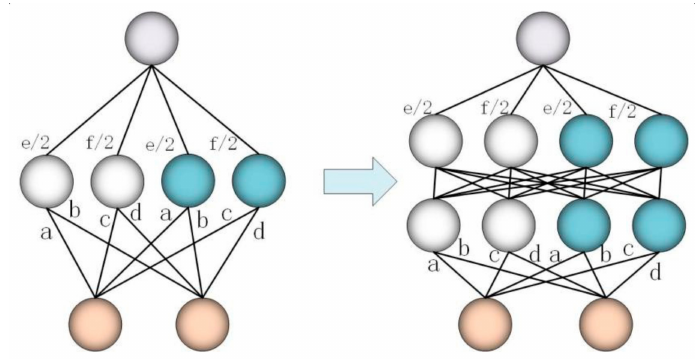
Figure 6. Perform a one-step process of expanding the network